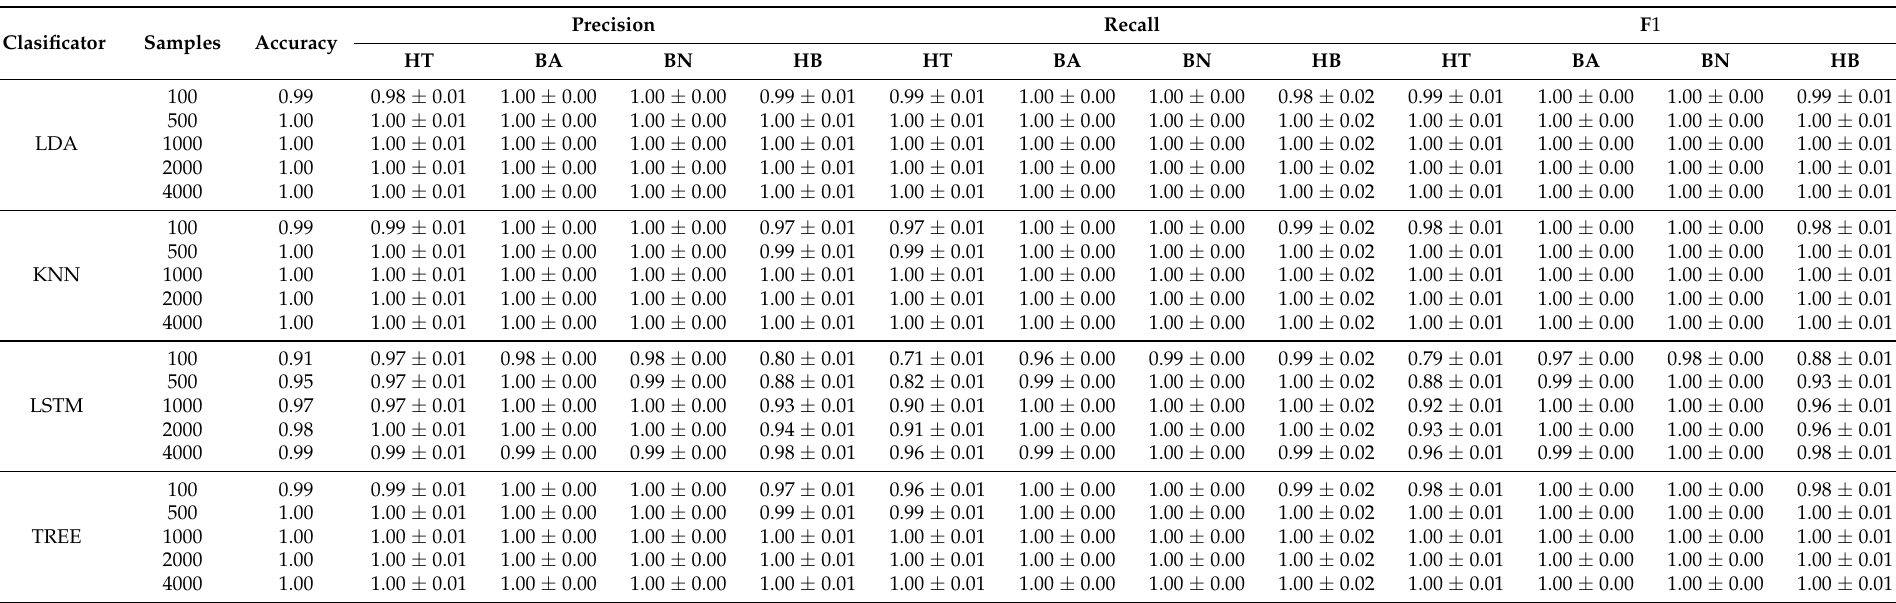
Table 1. Accuracy, precision, recall, and F1 of four single